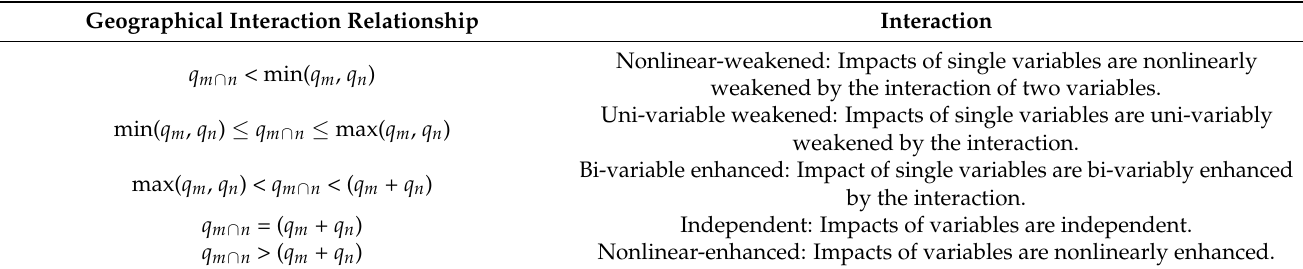
Table 4. Interactions between two explanatory variables and their interactive impacts. Geographical Interaction Relationship